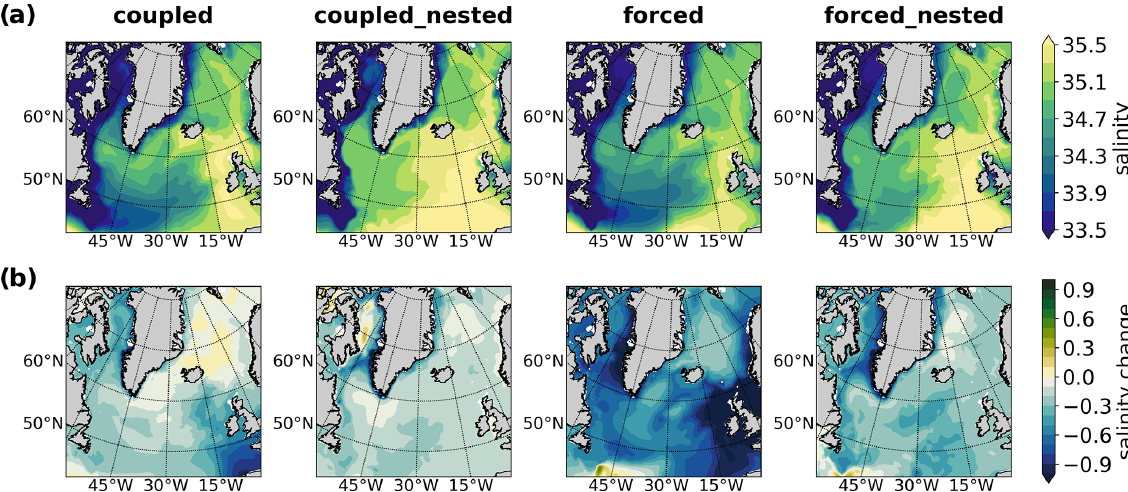
Figure 5. (a) Long-term mean state of upper-ocean (0–200m) annual-mean salinity and (b) the change due to the freshwater perturbation. The response is computed as the difference in the means over years 51–100 and 43–62 in the coupled and forced cases,